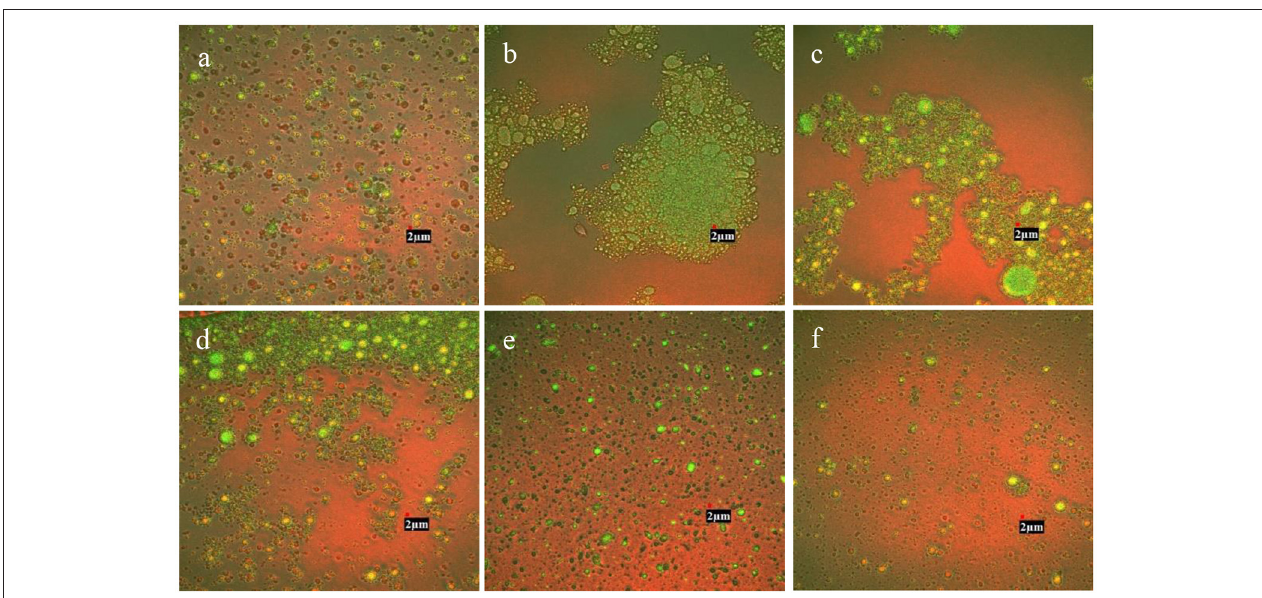
FIGURE 3 | The confocal laser scanning microscopy images of the SPI-stabilized rice bran oil emulsions with different concentrations of CMC at pH 3.5, 25 ◦ C [ (A) 0 wt% CMC; (B) 0.125 wt% CMC; (C) 0.25 wt% CMC; (D) 0.375 wt% CMC; (E) 0.5 wt% CMC; and (F) 0.625 wt% CMC]. All the photos were magnified at